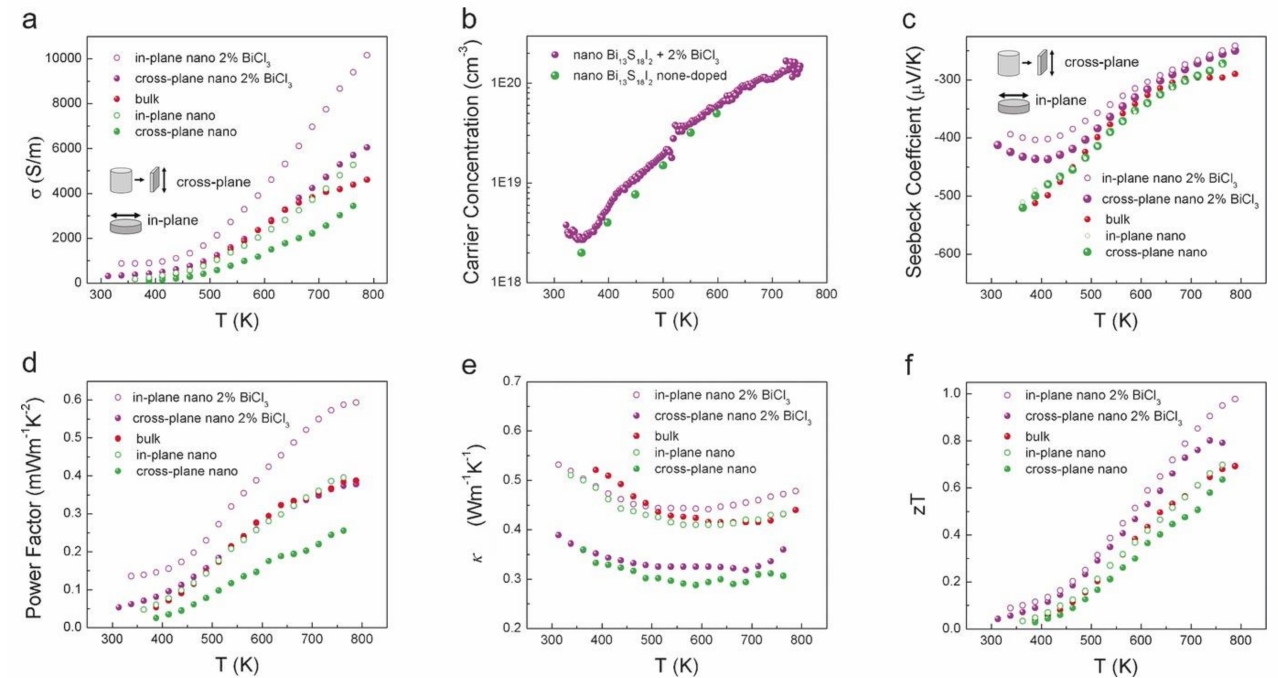
Figure 5. Temperature-dependent thermoelectric performance of the three Bi 13 S 18 I 2 samples (bulk, nano & nano with 2% BiCl 3 ) ( a ) Electrical conductivity, ( b ) Hall Carrier concentration, ( c ) Seebeck Coefficient, ( d ) Power Factor, ( e ) Thermal Conductivity, ( f ) Figure of merit (ZT), Reproduced with permission [49]. Copyright © 2018, Wiley Online